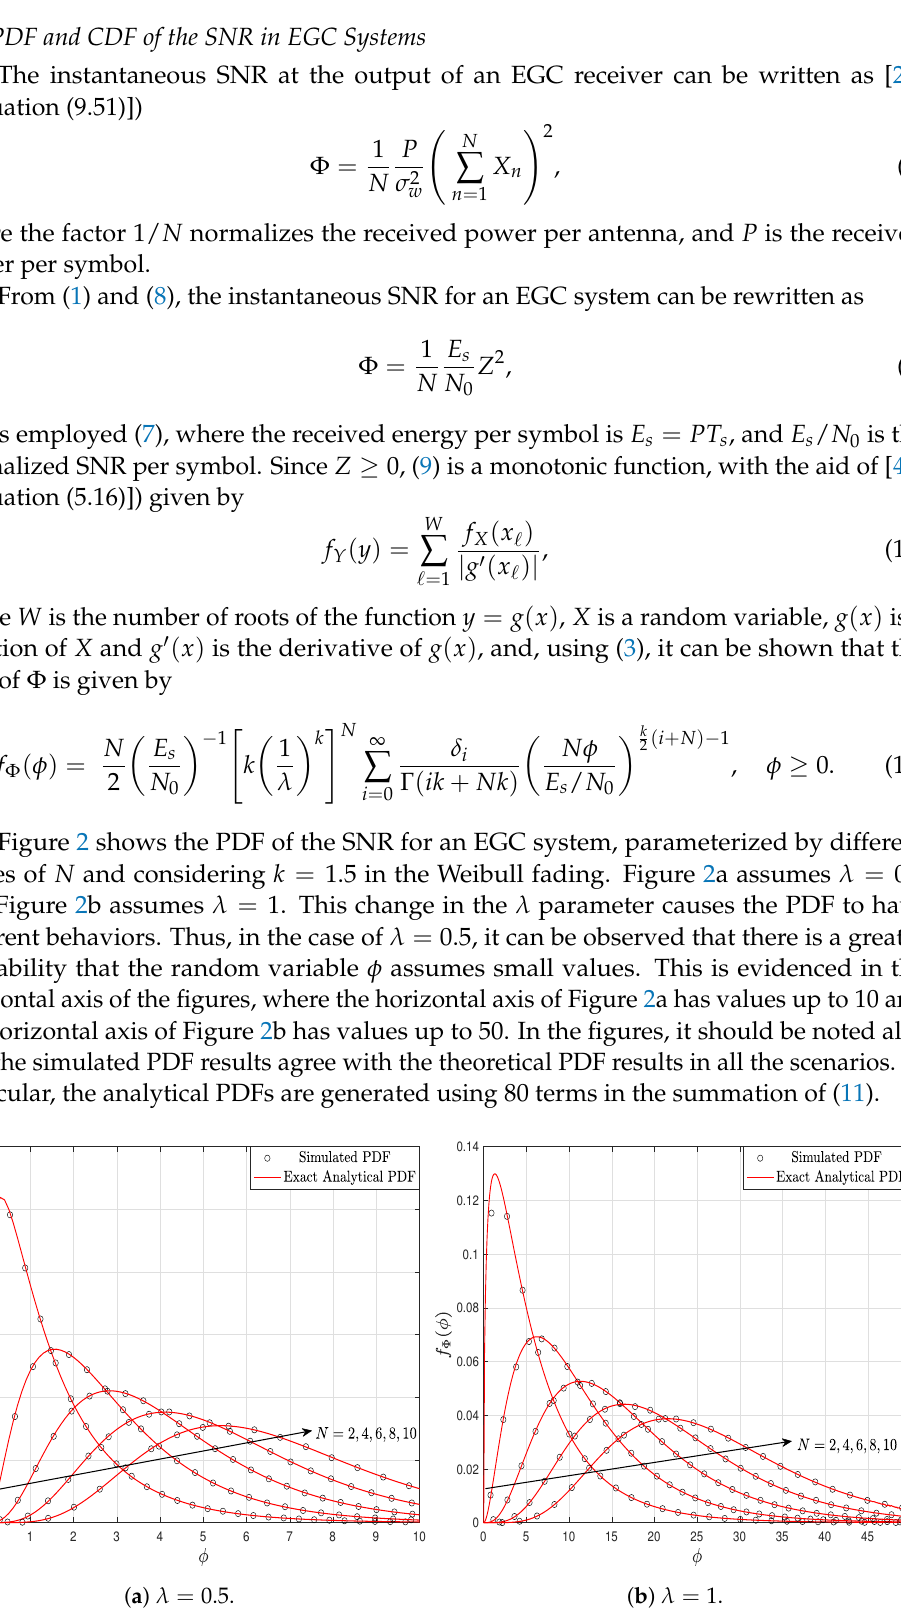
Figure 2. PDF of the SNR for an EGC system, parameterized by N , and λ considering k =